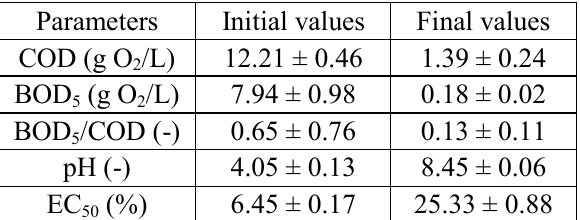
Table 1. Physico-chemical characteristics of leachate from biowaste at the beginning and at the end of biodegradation experiment